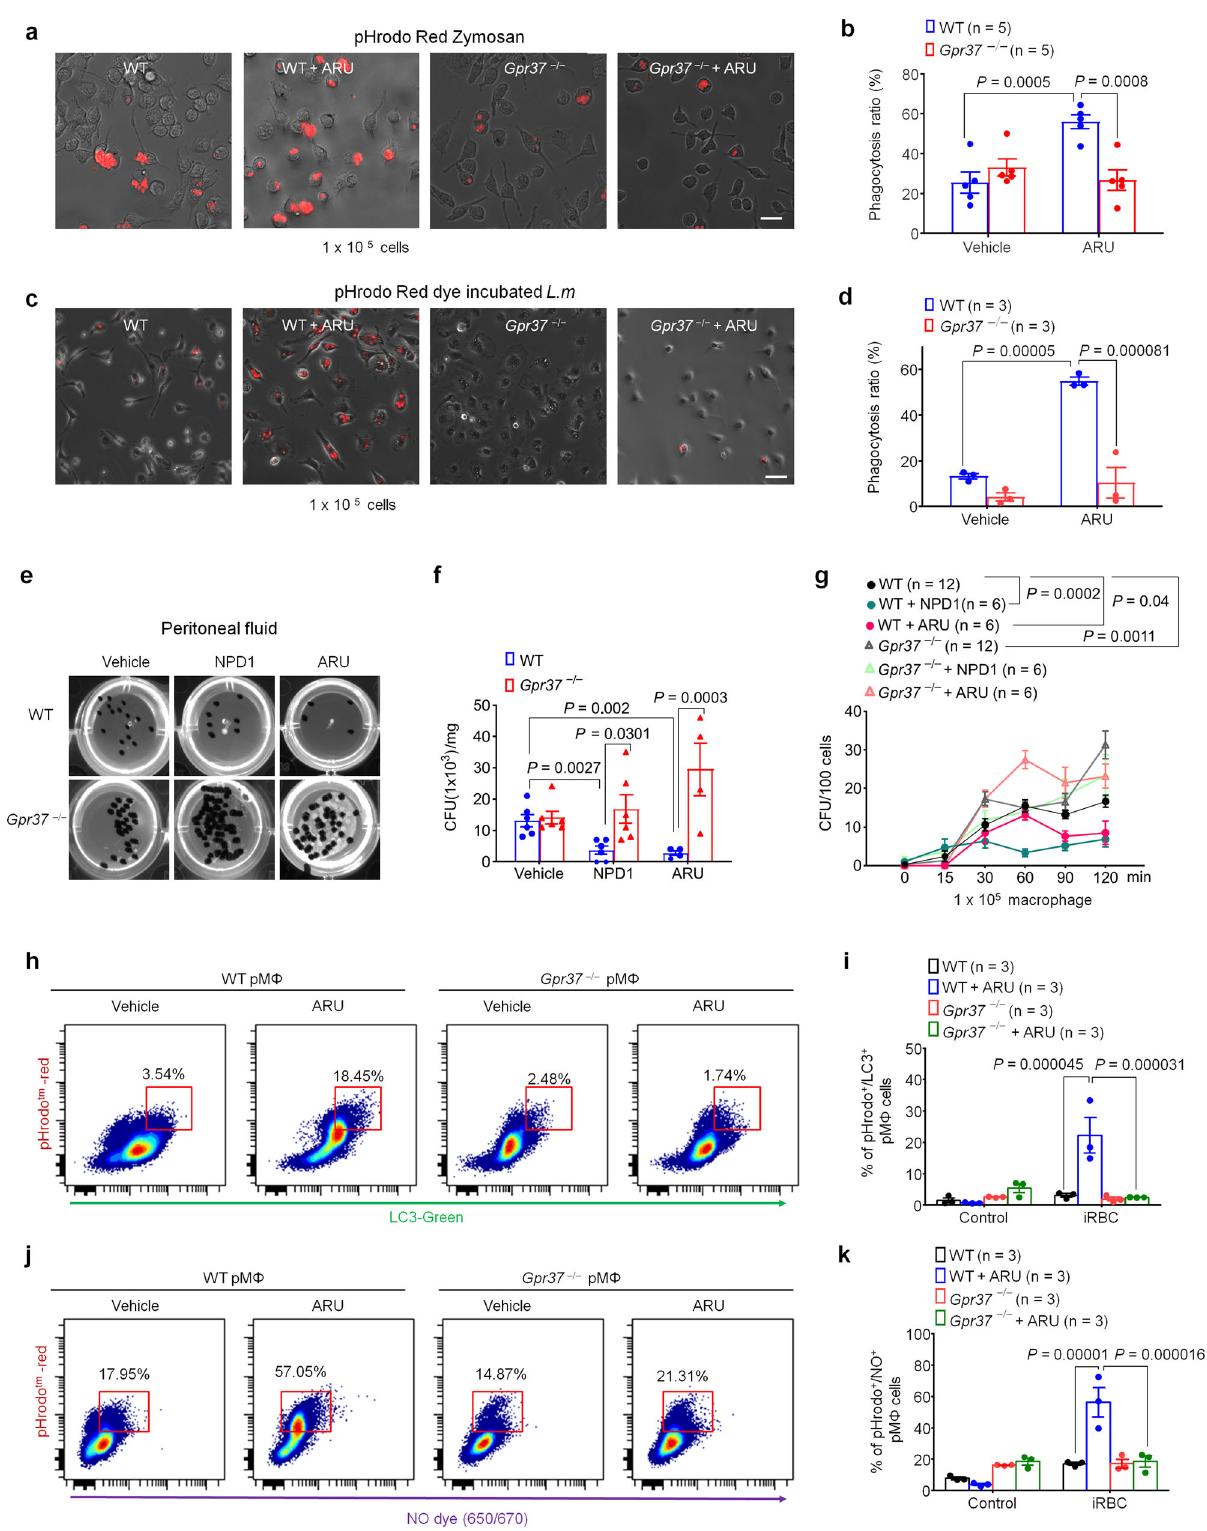
was abolished in Gpr37 -KO mice ( P = 0.0311, Fig. 5f). ARU also protected against L.m .-induced hypothermia ( P = 0.0194, Fig. 5g) and IL-6 production ( P = 0.0072, Fig. 5h) in WT mice. The pro- tective effect of ARU against hypothermia was abolished in KO mice ( P = 0.0007, Fig. 5g), as in the LPS model. Together, these data suggest that ARU confers GPR37-dependent protection